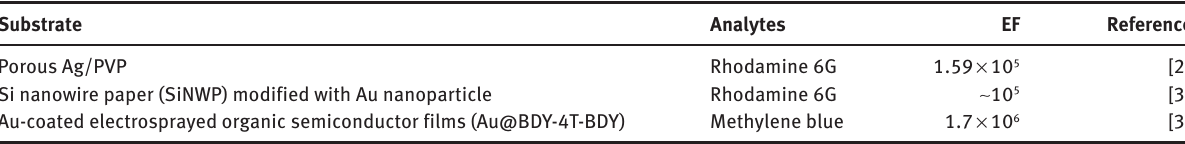
Table 1: The sensitivity of different flexible SERS